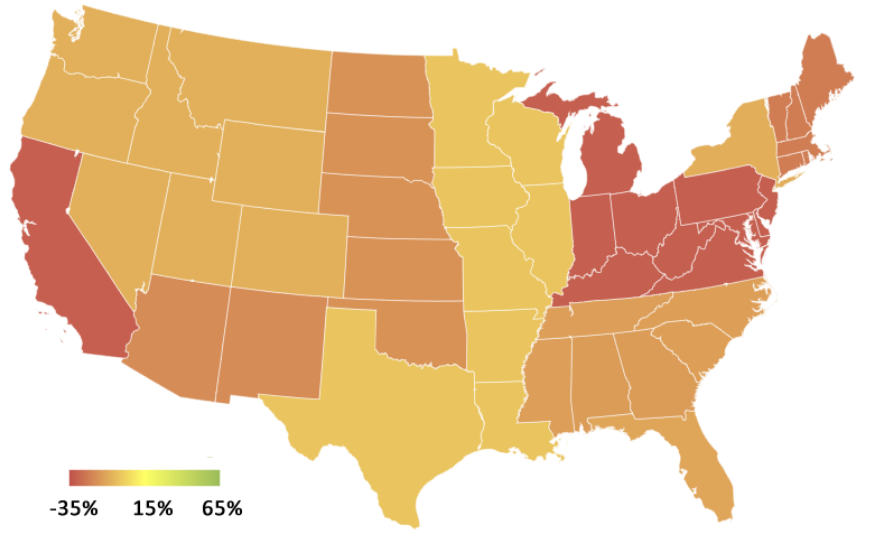
Figure 12. Charging and distributed PV generation in 2030.